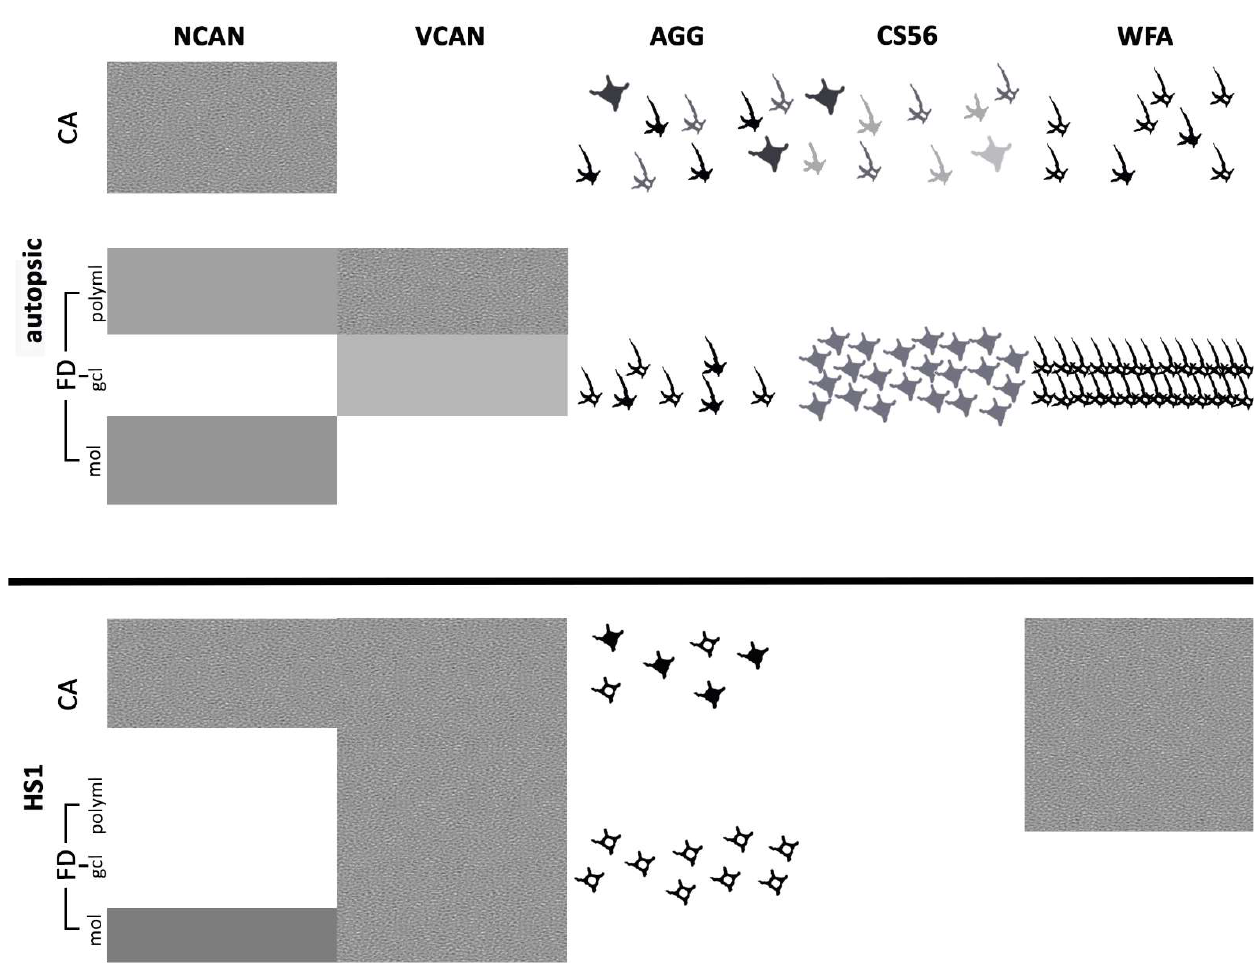
Figure 8. Schematic summary of the key differences in expression of ECM components between autopsic ( upper half ) and HS1 ( lower half ) hippocampi. The main change of neurocan expression is the diffuse-ir in the FD layers in HS1. Versican is expressed faintly diffusely in the gcl and polyml but firmly in all layers of the hippocampus. Note the reduction of aggrecan-ir cell density and the faint-ir of dendrites following HS1 compared to autopsic hippocampi. The CS56 staining is absent in HS1. The prominent change of glycosylation, shown by WFA staining, is the conversion of the extracellular staining associated with PNNs in autopsic specimens to the overall diffuse extracellular staining in HS1. Note the reduction in the size of HS1 hippocampal layers. Diffuse-ir of ECM components is noted with different shading of grey. Intracellular and extracellular expression of ECM components is presented by grey or black schematic drawings of cells and their processes. FD—fascia dentata;